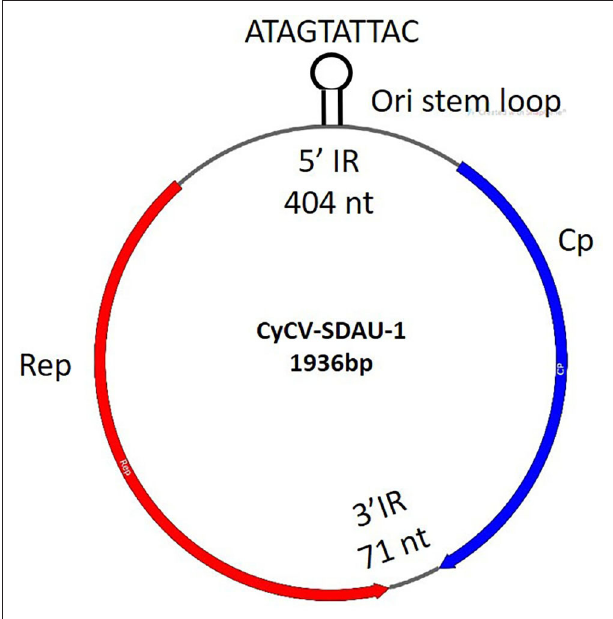
FIGURE 1 | Gene structure comparison between CyCV-SDAU-1 and three other chicken cycloviruses. Compared with CyCV-SDAU-1, the other three cycloviruses showed circovirus